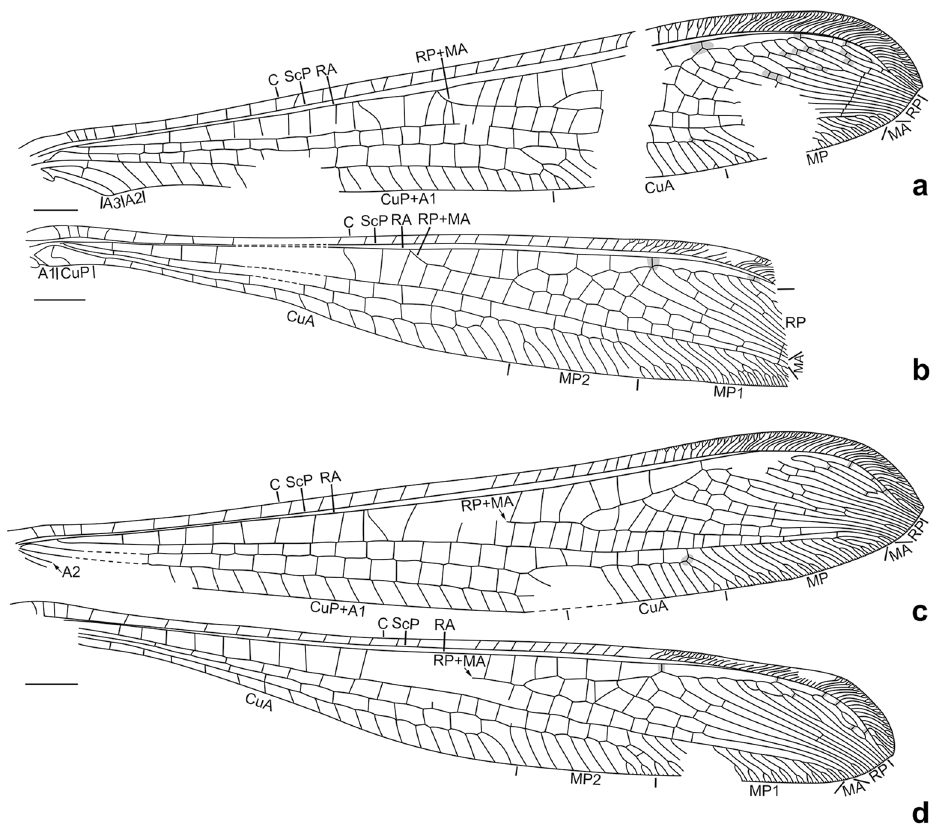
Figure 5. Stenobabinskaia punctata sp. nov., holotype male. ( a ) drawing of left forewing (drawn by XML); ( b ) drawing of left hind wing (drawn by XML); ( c ) drawing of right forewing (drawn by XML); ( d ) drawing of right hind wing (drawn by XML). Scale bar = 1.0